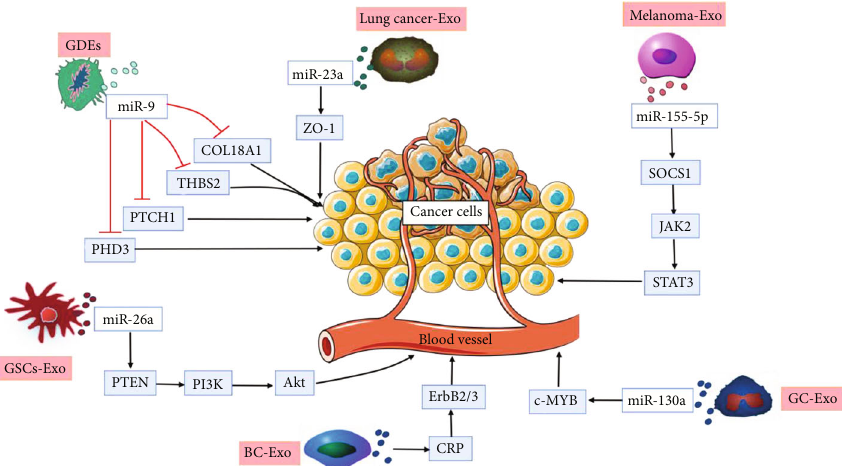
Figure 2: CSC-Exos regulate angiogenesis in cancer. Exosomes derived from lung cancer cells carry miR-23a, which target ZO-1 and promote angiogenesis in cancer. Melanoma cell-derived exosomal miR-155-5p induces a proangiogenic switch of cancer-associated fi broblasts via the SOCS1/JAK2/STAT3 signaling pathway. Exosomes derived from bladder cancer (BC) cells carry CRK, which promotes the expression of ErbB2/3 in BC cells and induces vascular growth in BC. Exosomes derived from gastric cancer (GC) cells contain miR- 130a, which induces activation of c-MYB-related angiogenic factors and thereby promotes vascular growth. Glioma cell-derived exosomes (GDEs) carry miR-9, which targets and inhibits COL18A1, THBS2, PTCH1, and PHD3 to promote angiogenesis. miR-26a carried by glioma stem cell-derived exosomes (GSCs-Exo) activates the PI3K/Akt pathway by targeting PTEN to promote angiogenesis in human brain microvascular endothelial cells